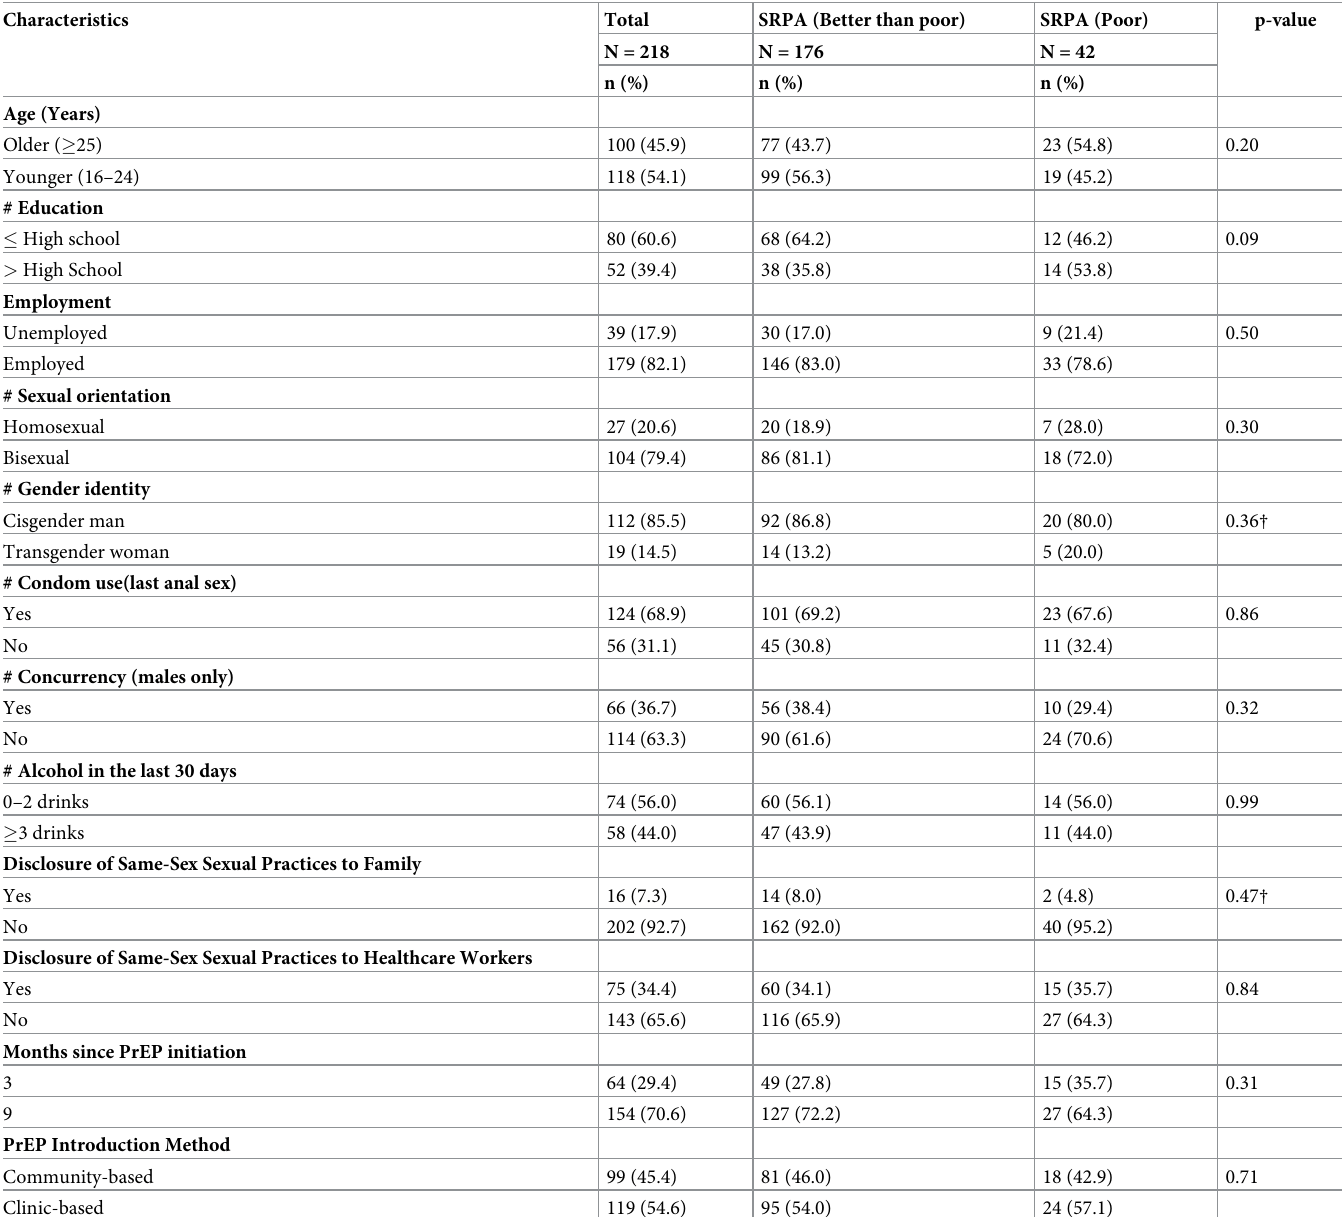
Table 1. Characteristics of respondents stratified by last reported self-reported adherence status.